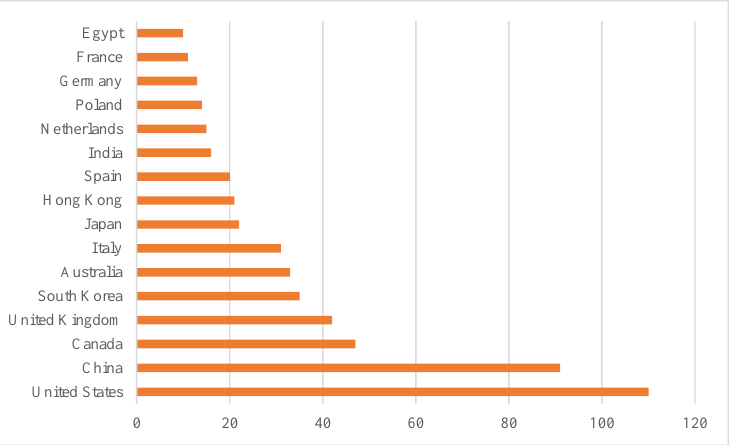
Figure 4. The number of UI-related journal papers published by different countries or regions.